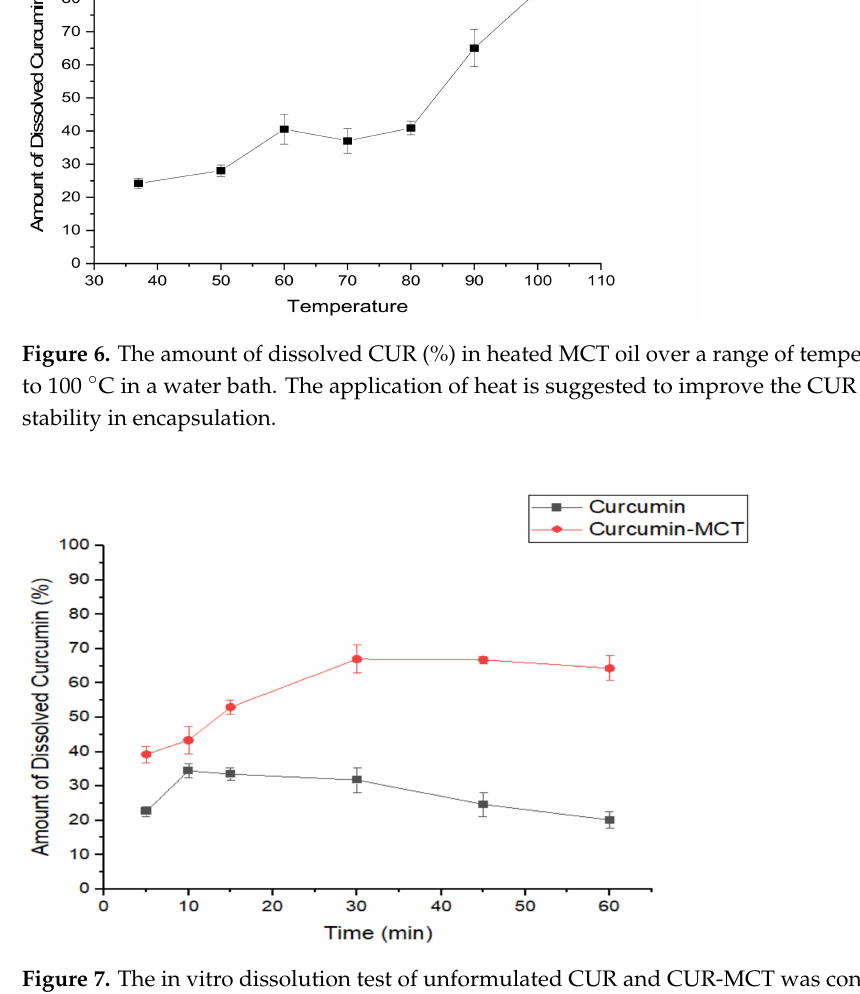
Figure 7. The in vitro dissolution test of unformulated CUR and CUR-MCT was conducted in PBS over 60 min at temperature 37 ◦ C with gentle shaking of 150 rpm in a shaking incubator. MCT plays an important role in enhancing the CUR